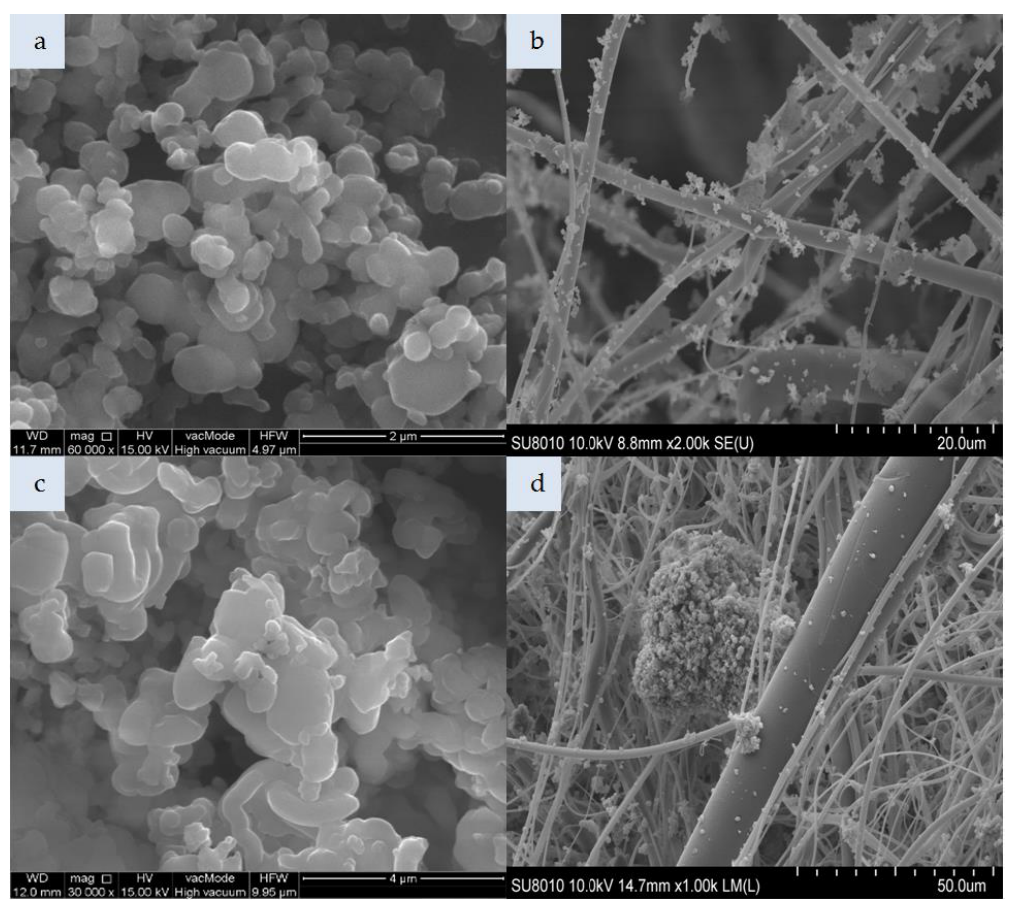
Figure 4. SEM photomicrograph: ( a ) Mesoporous silica material (MCM-41), ( b ) nonwoven composite with MCM-41, ( c ) MCM-41 modified with HDTMA, ( d ) nonwoven composite with MCM-41 HDTMA (magnification: a—x60.00k, b—x2.00k c—x30.00k; d—x1.00k).